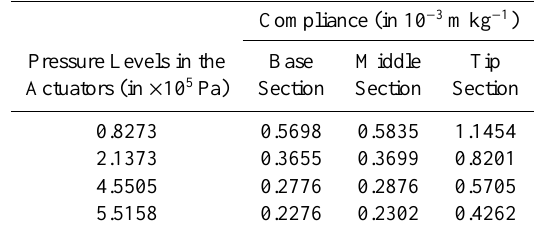
Figure 10. The Octarm - grasping and acquiring a moving object. Table 1. Compliance of all three sections (measured in a distance perpendicular to z-axis indicated in Fig.